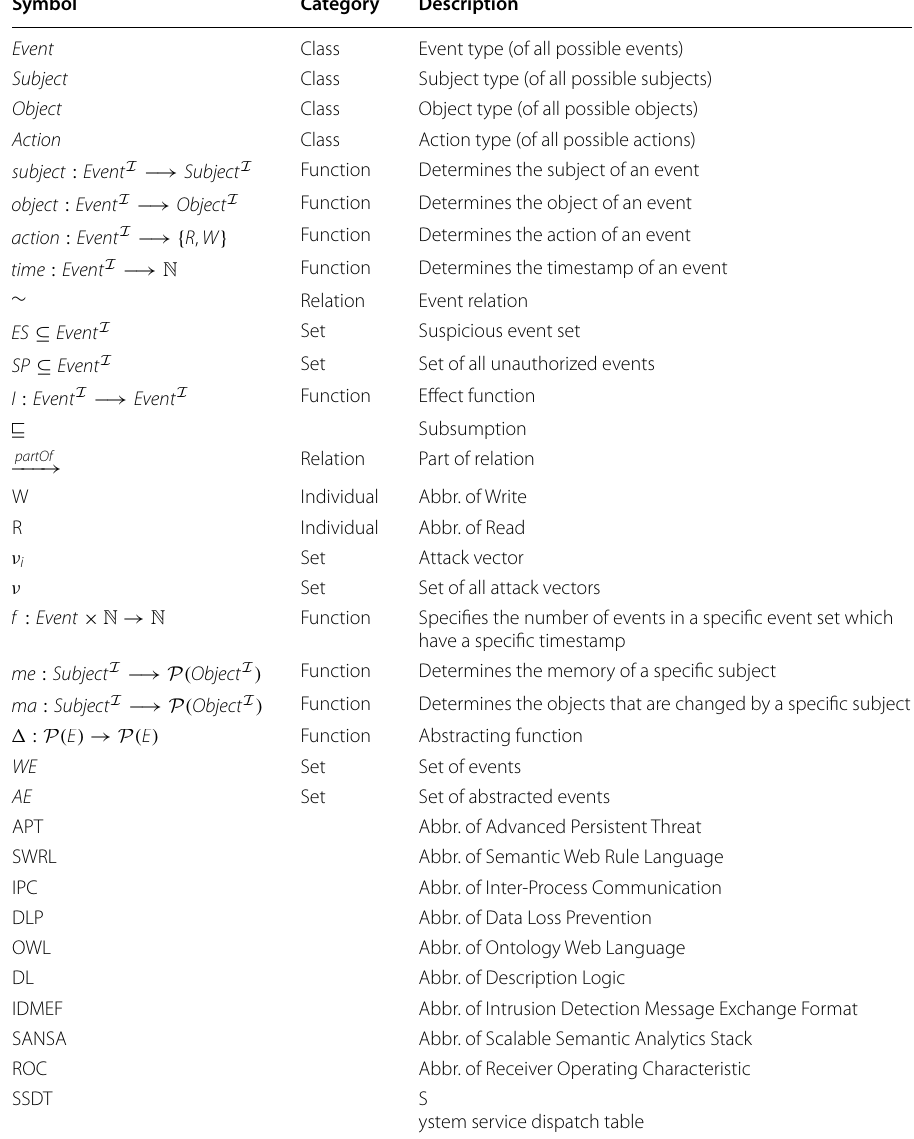
The symbols, which are defined and used in this paper, are listed in Table 16. Table 16 List of the symbols used in the paper